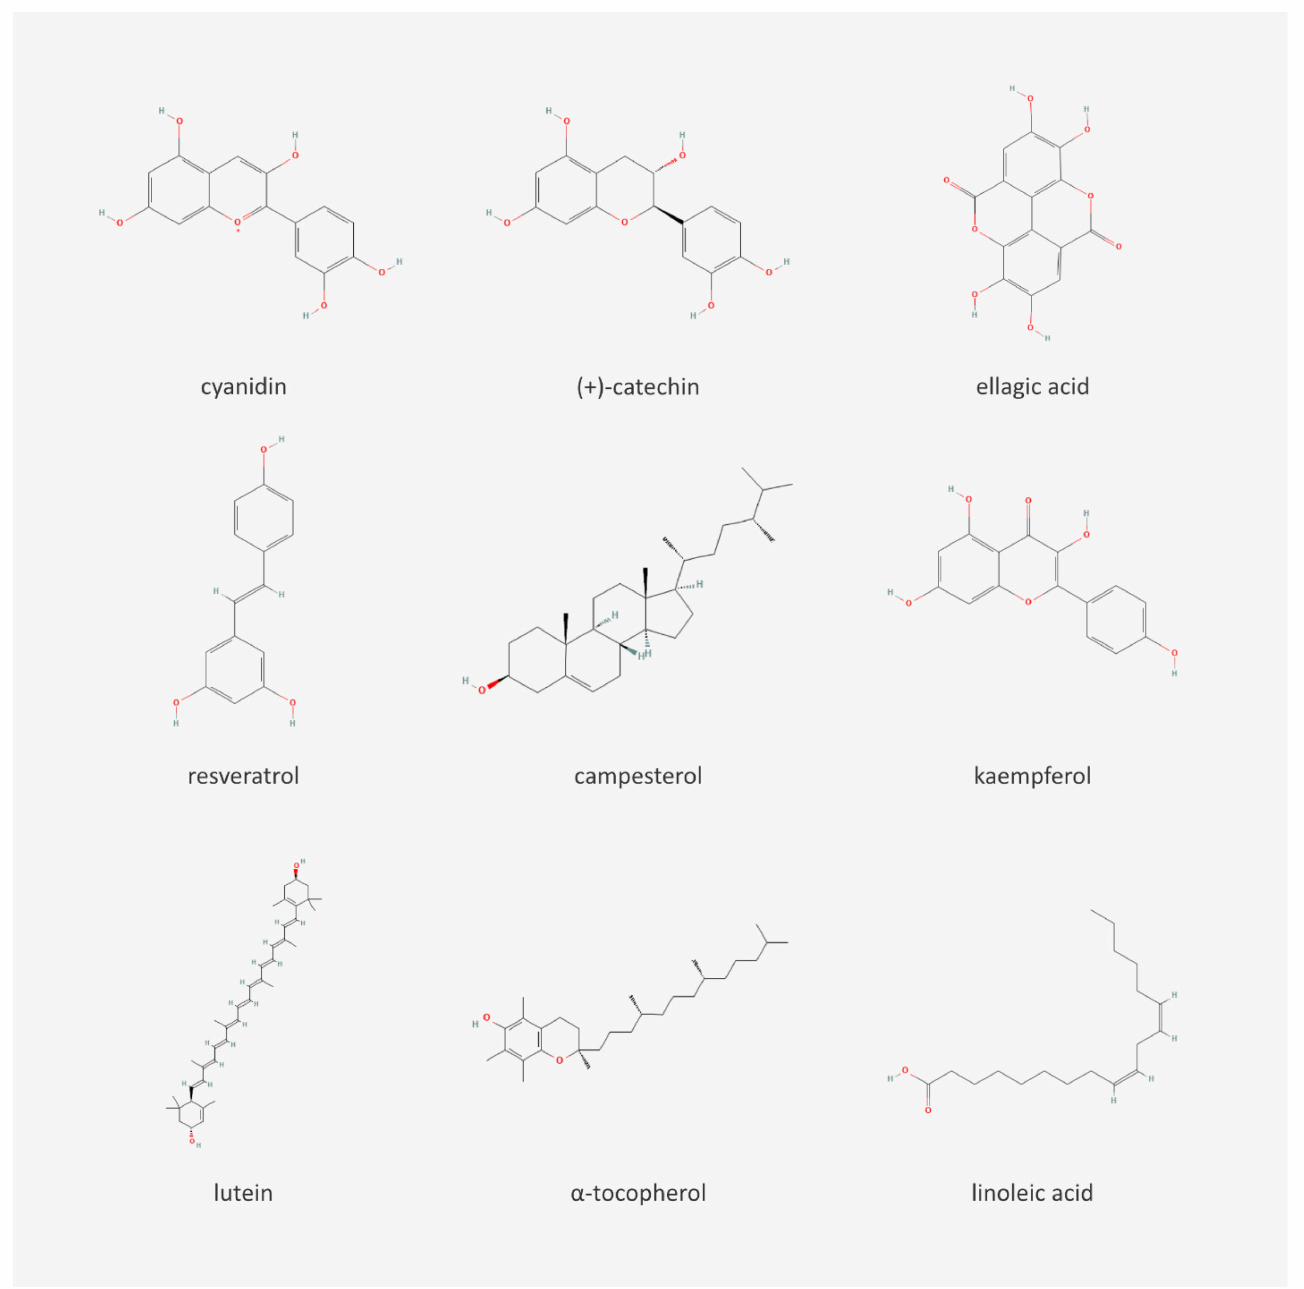
Figure 2. Chemical structures of selected compounds present in berry seeds